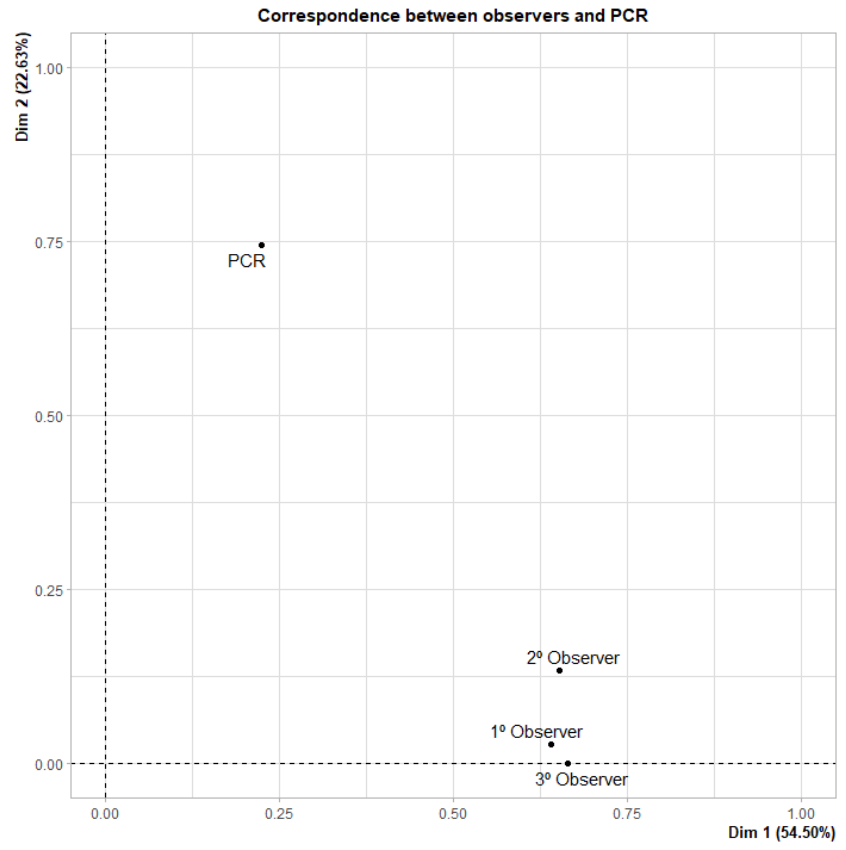
Figure 2. Proximity